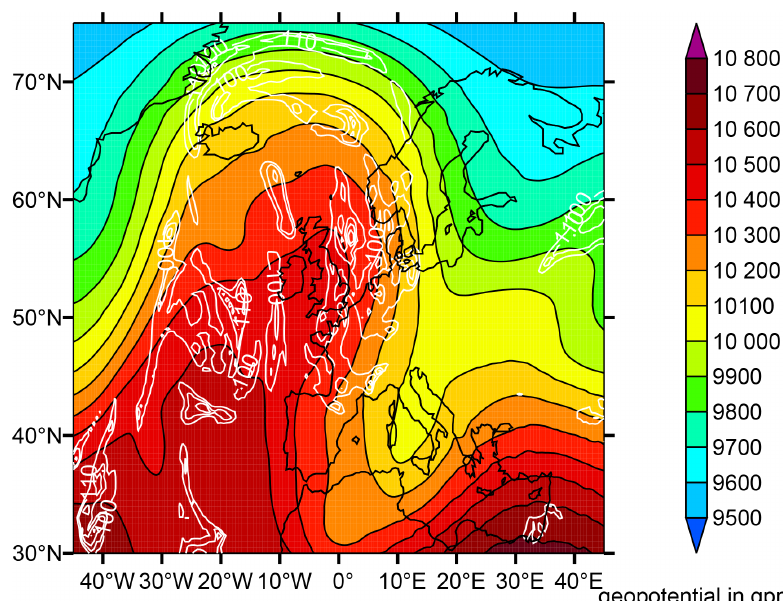
Figure 2. Geopotential height (colour coding) and ice supersaturation (white contours, starting at saturation, increment 10%) on the 250hPa level at 18:00UTC on 21 March 2021.